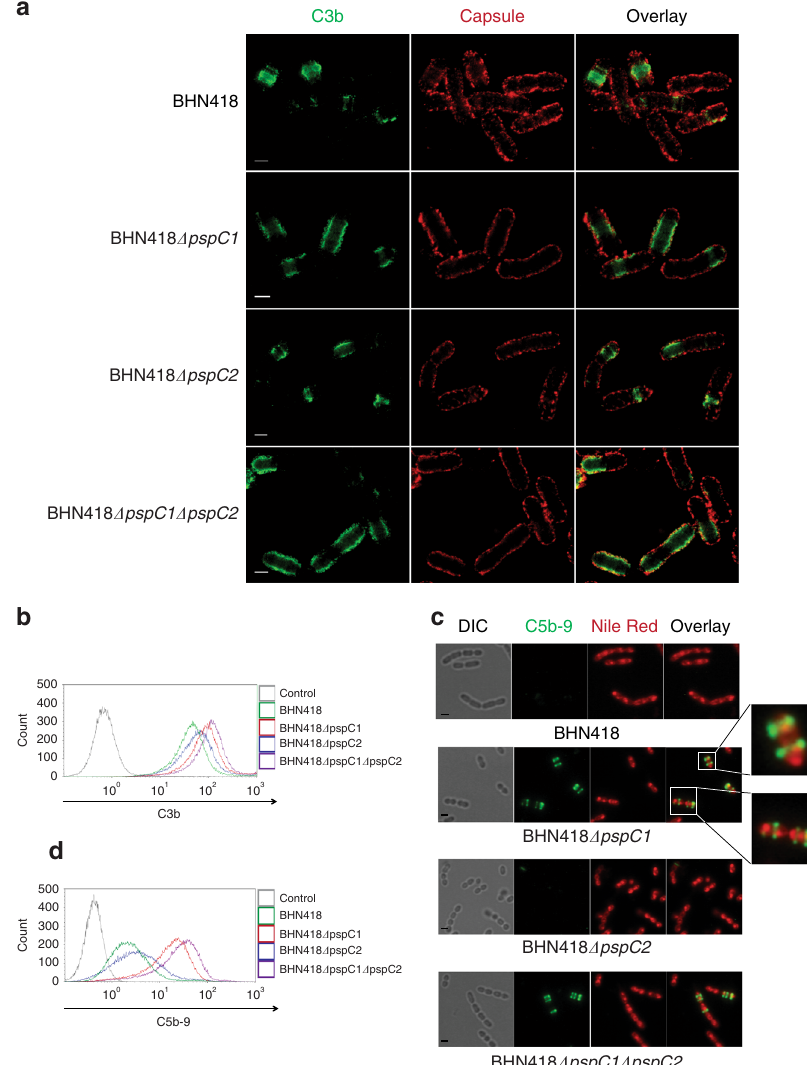
Fig. 5 PspC1 protects division sites from C3b deposition and MAC complex formation, and prevents lateral C3b ampli fi cation within the cell wall. a Representative super-resolution STED microscopy images of C3b deposition on wt BHN418 and its isogenic pspC deletion mutants after incubation with 20% normal human serum. C3b and the capsule were detected as in Fig. 2a. Scale bar = 1 µ m. b Representative histogram of C3b deposition on strain BHN418 and on its isogenic pspC deletion mutants after incubation with 20% normal human serum using fl ow cytometry. Bacteria were sequentially stained with goat anti-C3 antibody followed by FITC-labeled secondary antibody. c Representative immuno fl uorescence images of C5b-9 deposition on strain BHN418 and on its isogenic pspC deletion mutants after incubation with 20% normal human serum. Bacteria were stained as in Fig. 2b. Scale bar = 1 µ m. d Representative histogram of C5b-9 deposition on strain BHN418 and on its isogenic pspC deletion mutants after incubation with 20% normal human serum using fl ow cytometry. Bacteria were sequentially stained with mouse anti-C5b-9 antibody followed by anti-mouse Alexa fl uor 488 labeled secondary